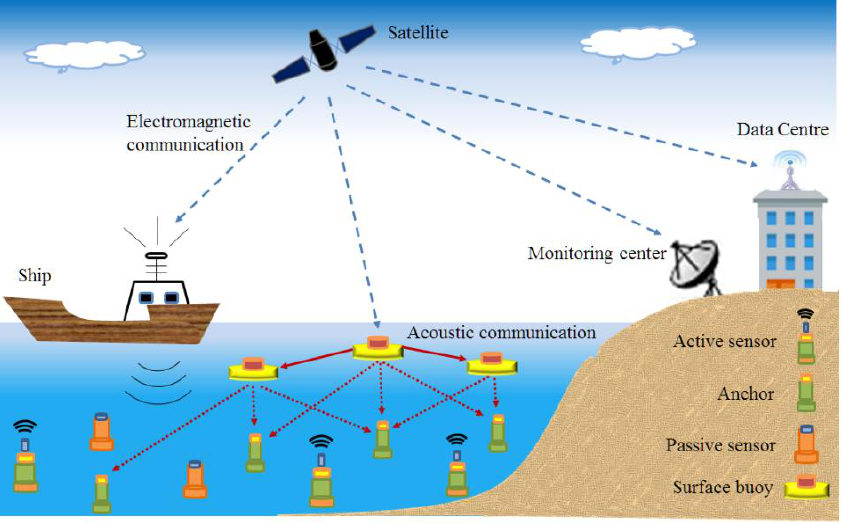
Figure 1. Illustration of an IoUT network.